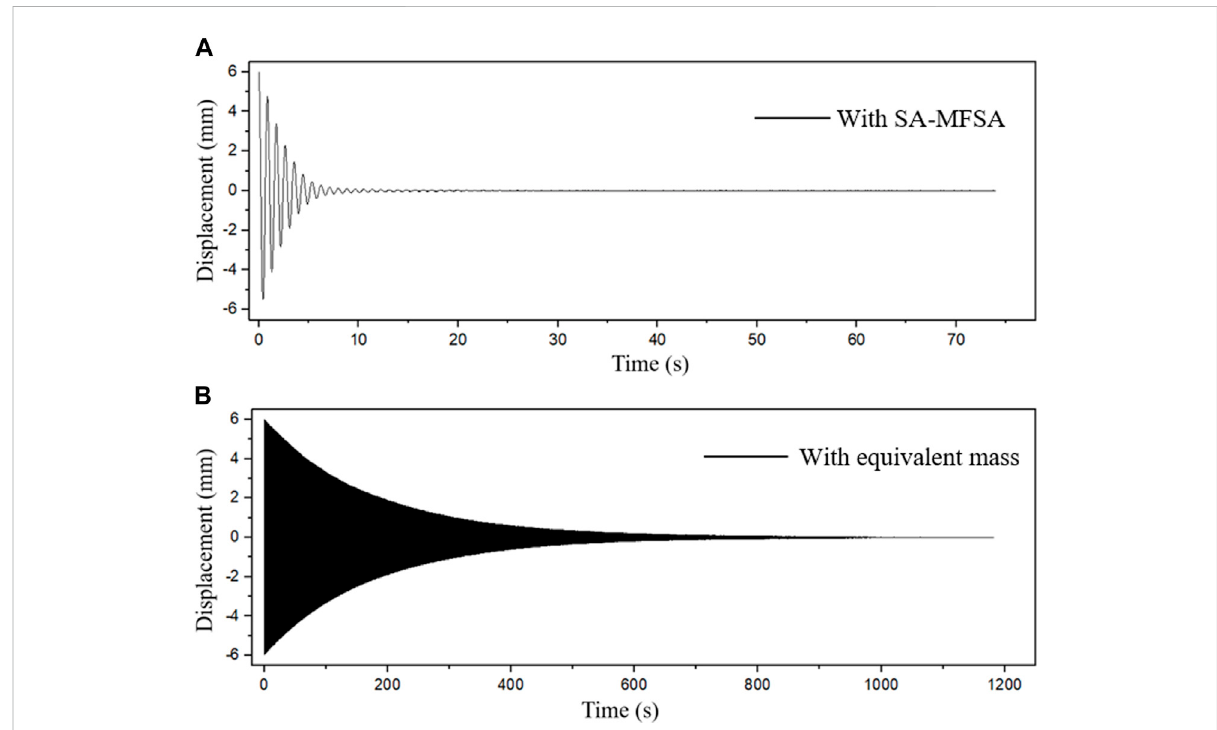
FIGURE 13 Displacement responses for initial excitation. (A) Response curve with VS-MFSA. (B) Response curve with equivalent mass.